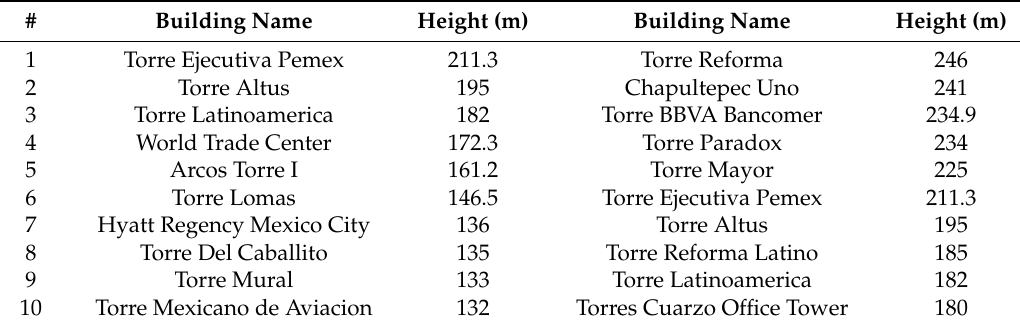
Figure 21. Mexico City in 2000 and 2020. Table 31. Mexico City’s 10 tallest skyscrapers in 2000 and 2020.